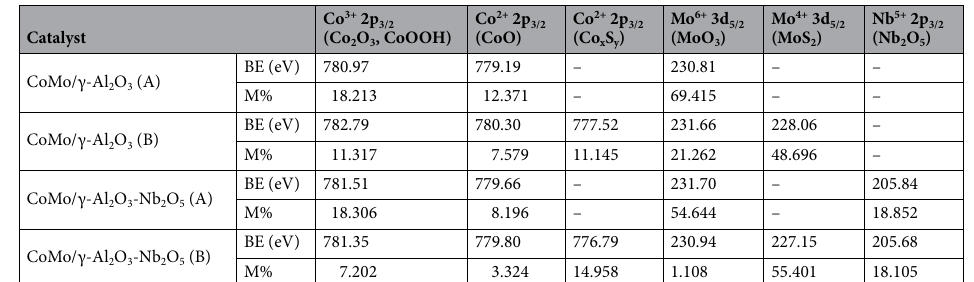
Table 3. Binding energies (eV) and mass percentage from fitting curve analysis, for metal species of catalysts before (A) and after sulphidation (B).